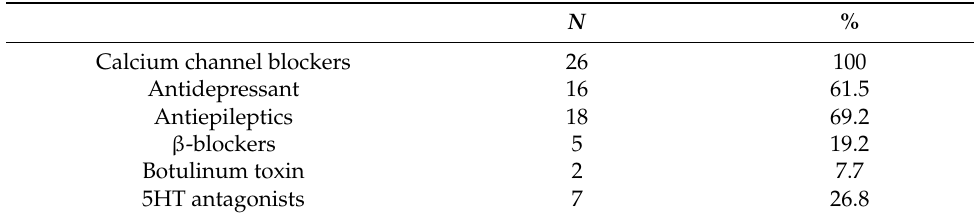
Table 2. Prior preventive treatment failure.